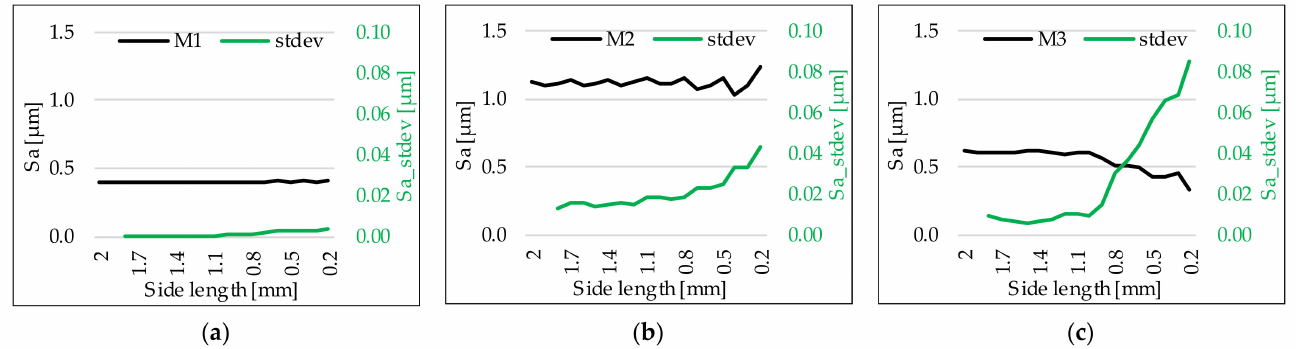
Figure 4. Sa parameters (black) and their standard deviations (green) as a function of the analyzed area (2 × 2 mm–